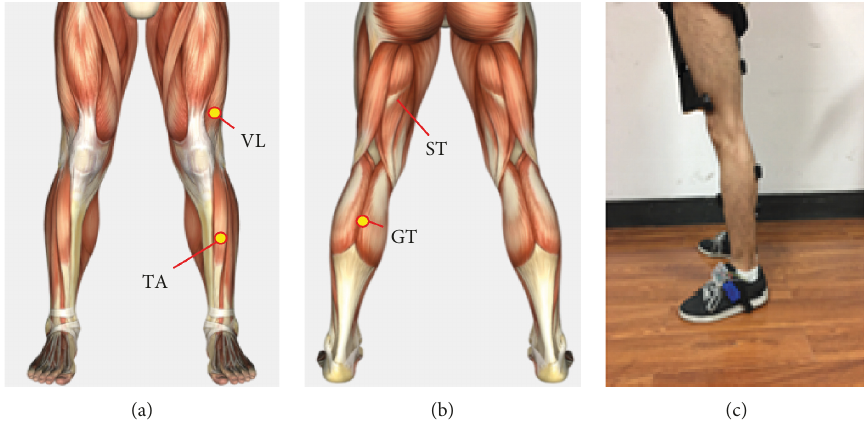
Figure 2: Muscle channels and sensor placement.